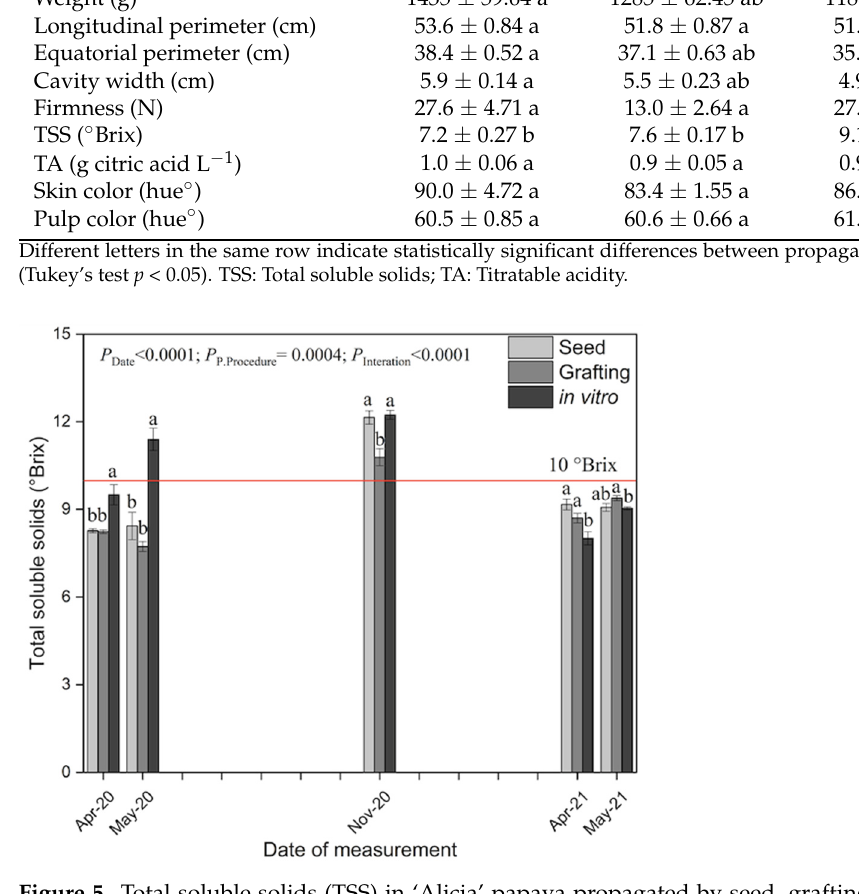
Figure 5. Total soluble solids (TSS) in ‘Alicia’ papaya propagated by seed, grafting, and in vitro ( n = 12 ± s.e.), evaluated from April 2020 to May 2021 at the maturation of 100% yellow skin color. The line marks the 10 °Brix value, commonly referred to as the minimum for papaya commercialization. Different letters on the same date indicate statistically significant differences between propagation procedures (Tukey’s test p <